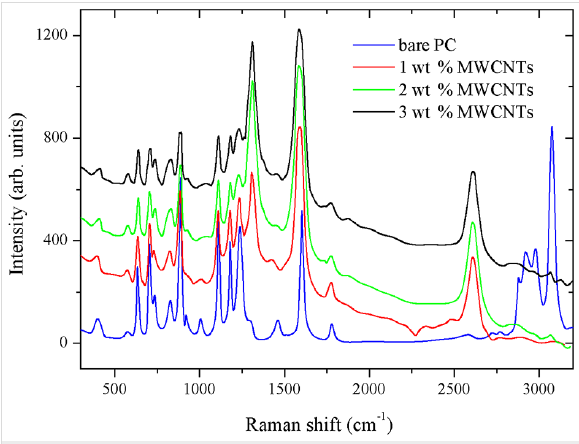
Figure 4: Raman spectra of PC/MWCNT composite films at different MWCNT loadings.